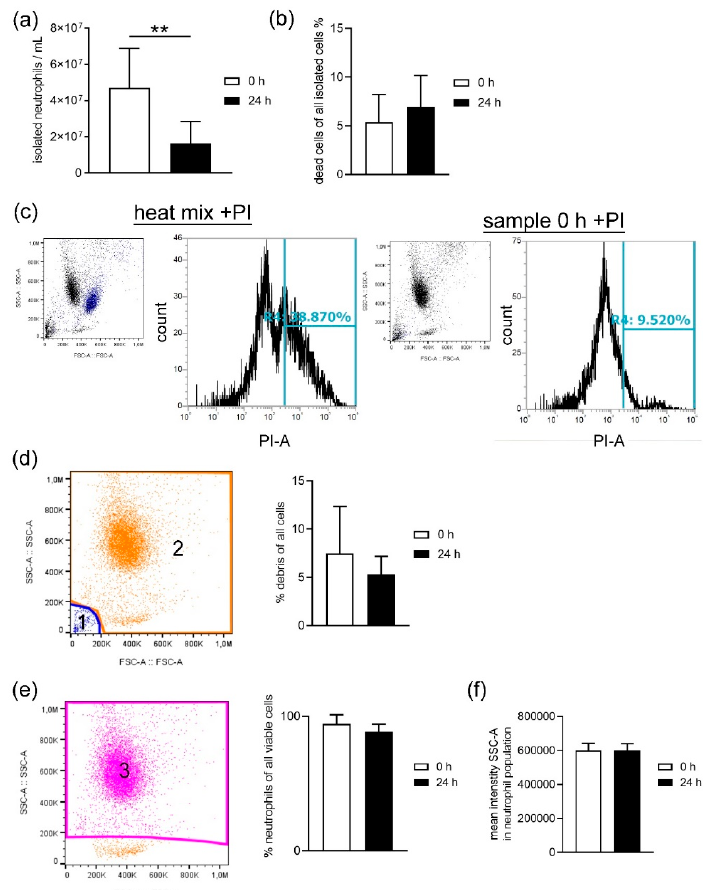
Figure 3. ( a ) Significantly less neutrophils (counted in a Neubauer chamber) were isolated from stored blood. ( b ) Slightly but not significant higher percentage of dead cells were detected in isolated cells from stored blood. ( c ) The gating strategy for the dead cell analysis after PI (propidium iodide) staining by flow cytometry is presented. Settings were adjusted with a 1:2 mix of heat-killed and living cells (heat mix). Blue points in the dot blot depict the dead cells identified by the histogram and respective gating (left panel). ( d , e ) The isolated cells were analyzed by flow cytometry for purity and granularity. ( d ) Based on FSC-A (forward scatter area) and SSC-A (side scatter area), the debris (blue dots) were excluded and viable cells were marked orange. The amount of debris was not significant different between fresh and stored blood. ( e ) Based on FSC-A and SSC-A, the neutrophil population (pink dots) were gated in the viable cell population. No significant difference in the percentage of neutrophils in the viable cell population was found. ( f ) The mean intensity SSC-A (granularity) was not different in the gated neutrophil population when compared with isolated cells from fresh and stored blood. Data were analyzed with one-tailed paired Student’s t -test (** p < 0.01) and presented with mean ±SD, (a: n = 7, b: n = 5, d-e: n = 4).